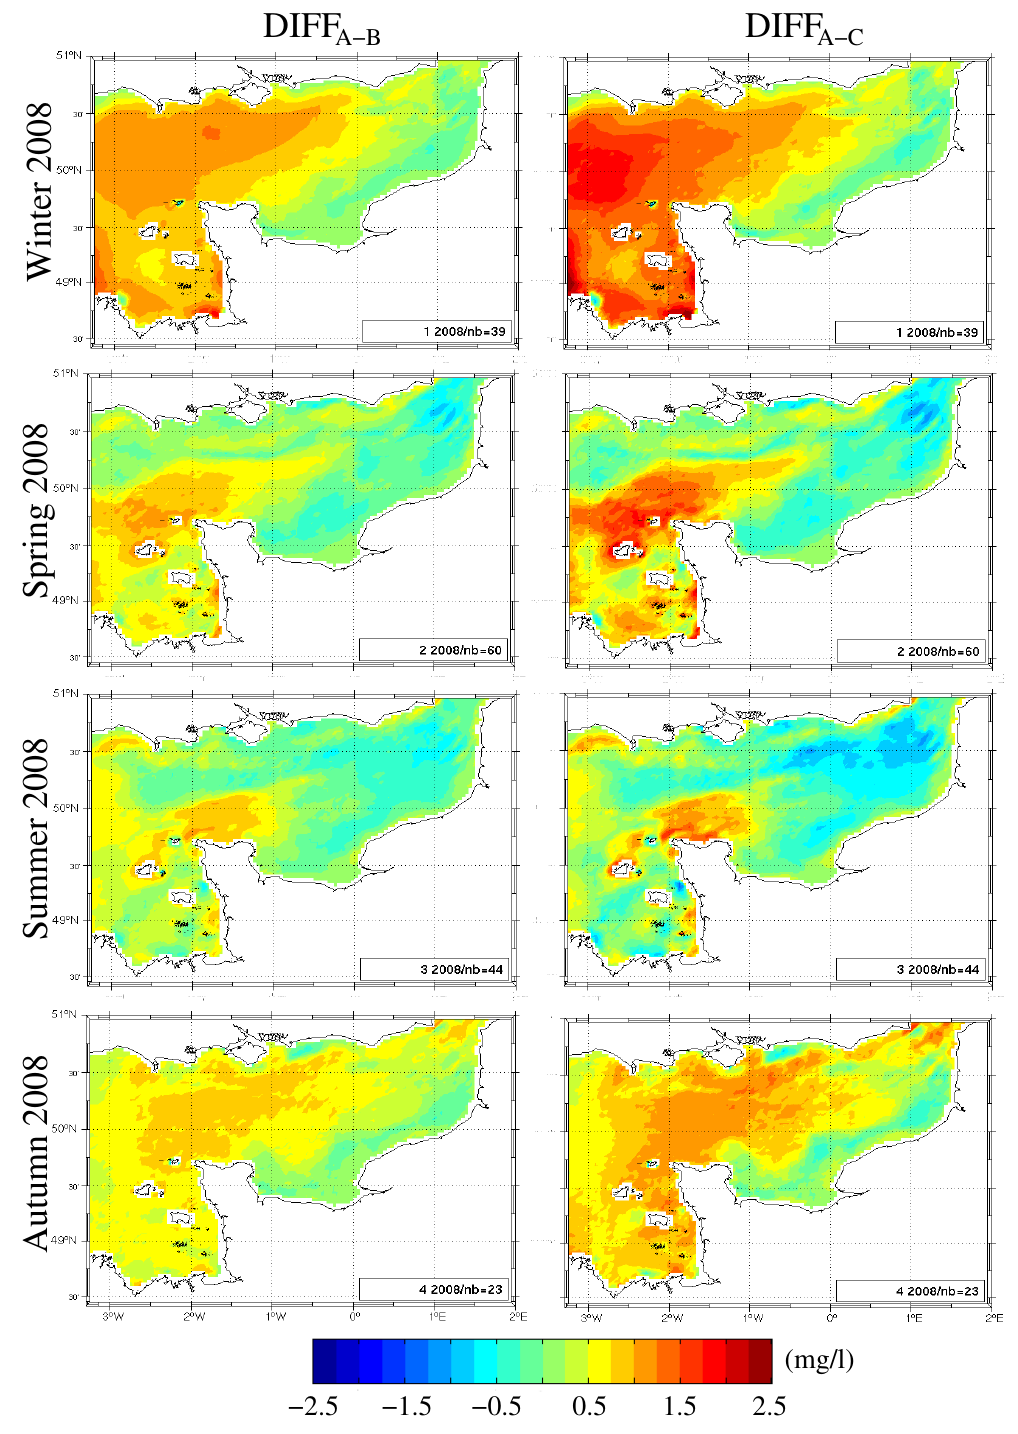
Figure 10. Differences in the estimation of observed near-surface SSC between Configurations ( left ) A and B (DIFF ) and ( right ) A and C (DIFF ) in winter, spring, A − B A − C summer and autumn 2008. Positive values show improved estimations with Configurations B and C,